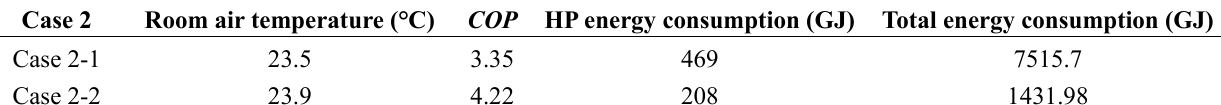
Table 10. Indoor environmental conditions for combination with the Multi-GHP systems and the ABS chiller-heater system.